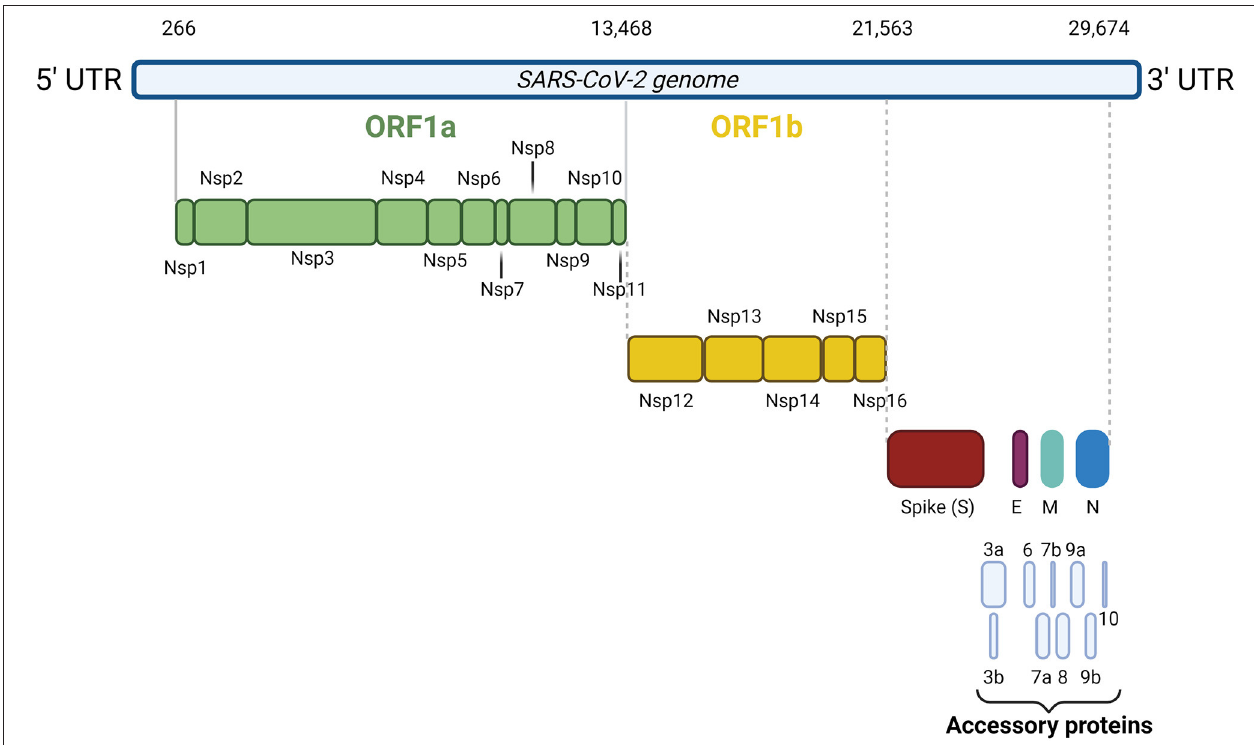
FIGURE 2 | SARS-CoV-2 genome organization. The 30kb SARS-CoV-2 genome is flanked by 5 ′ and 3 ′ untranslated regions. At the 5 ′ end, the genomic RNA contains two large open reading frames (ORF1a and ORF1b) encoding 16 non-structural proteins (Nsps 1–16). At the 3’ end, the genome encodes the four structural proteins S, N, M, and E and nine accessory proteins, namely ORF3a, 3b, 6, 7a, 7b, 8, 9a, 9b, and